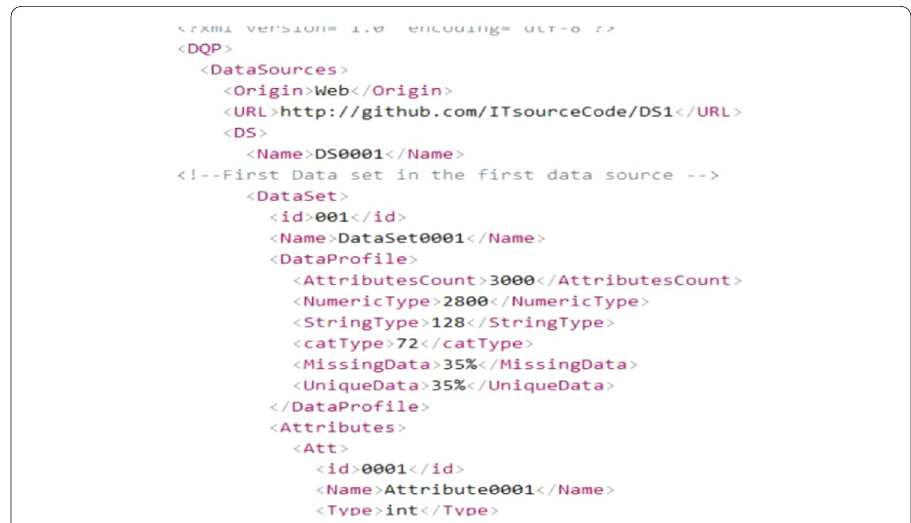
Fig. 13 Example of data quality